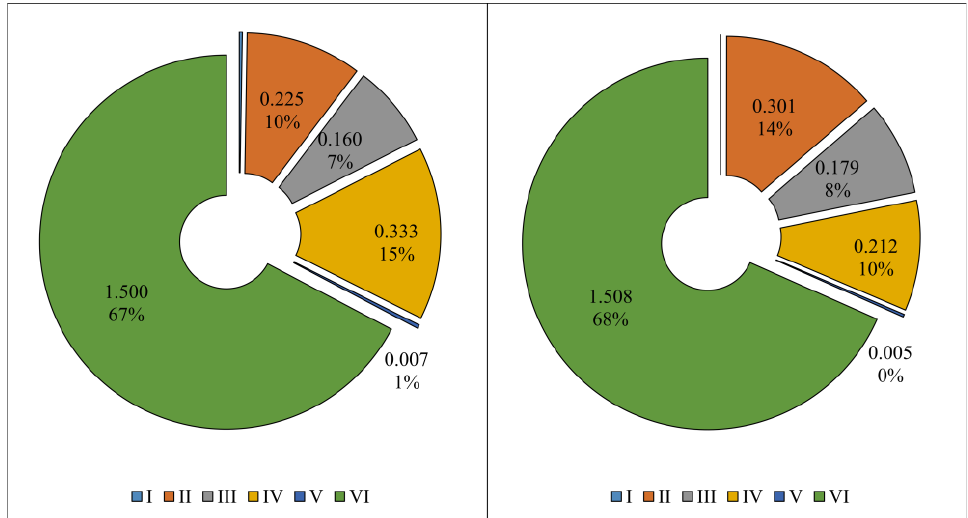
Figure 10. Shares of different U fractions in the sediments of Lake Raivattalanlampi (I—water-soluble fraction, II—exchangeable forms, III—hydrated Fe and Mn oxides, IV—organic matter, V—acid-soluble (residual) fraction, VI—mineral (stable) fraction).